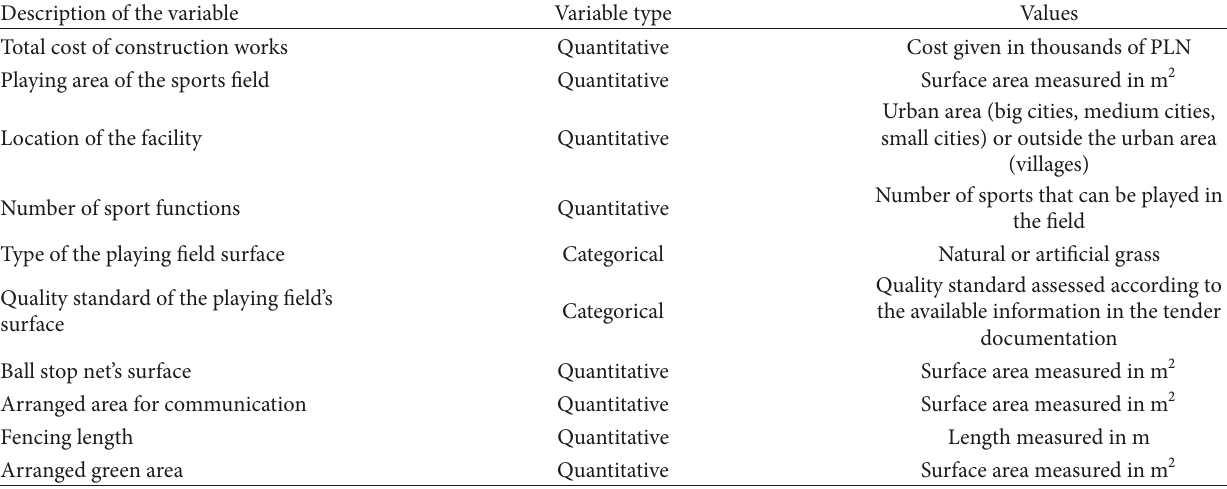
Table 1: Characteristics of dependent variables and independent variables considered initially to be used in the course of a regression analysis (source: own